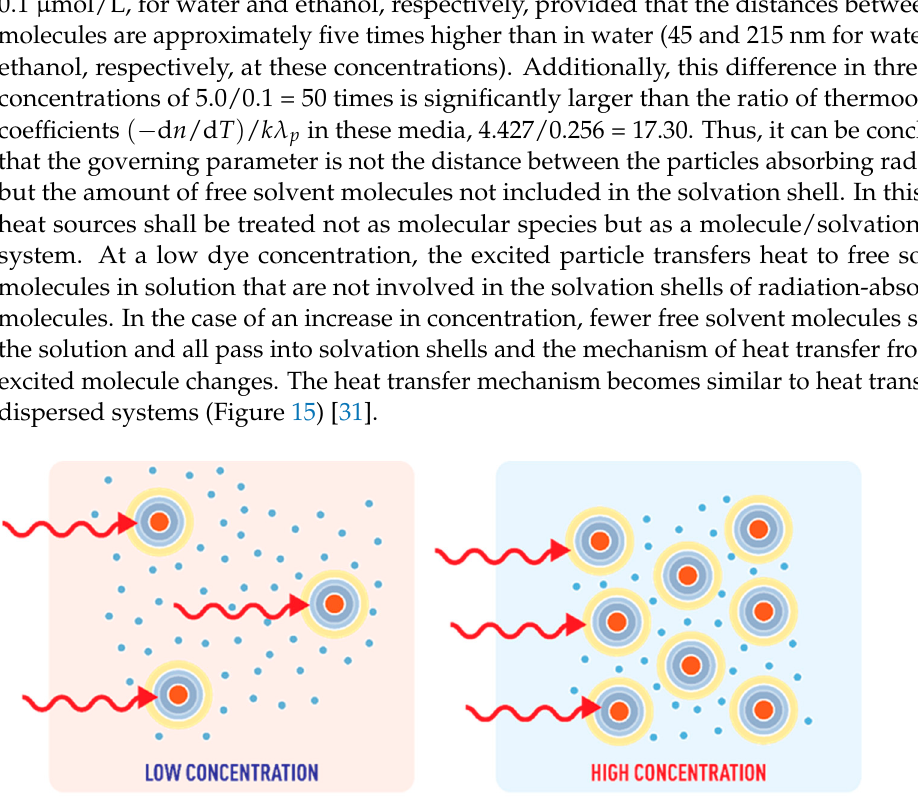
Figure 14. Transient curves in the normalized form of a solution of Sudan I in ethanol (2.5 µmol/L) at different excitation laser powers; middle-focused configuration ( ω e 0 = 42 µ m, Figure 2, Table 3). Based on our results, the highest limit of concentration for organic solvents (in par- ticular, for ethanol) in TLS is more than an order of magnitude lower than for water: 5.0